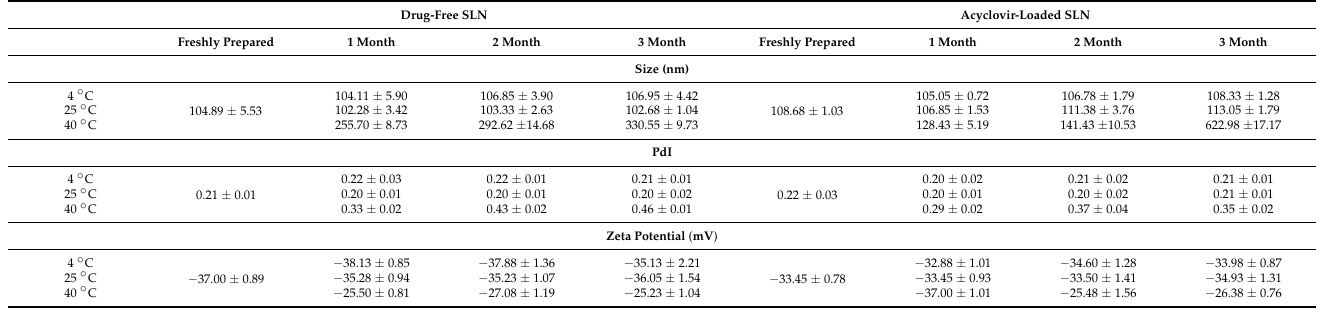
Table 4. Size, PdI and zeta potential measurement of SLN formulations stored at 4, 25 and 40 °C.